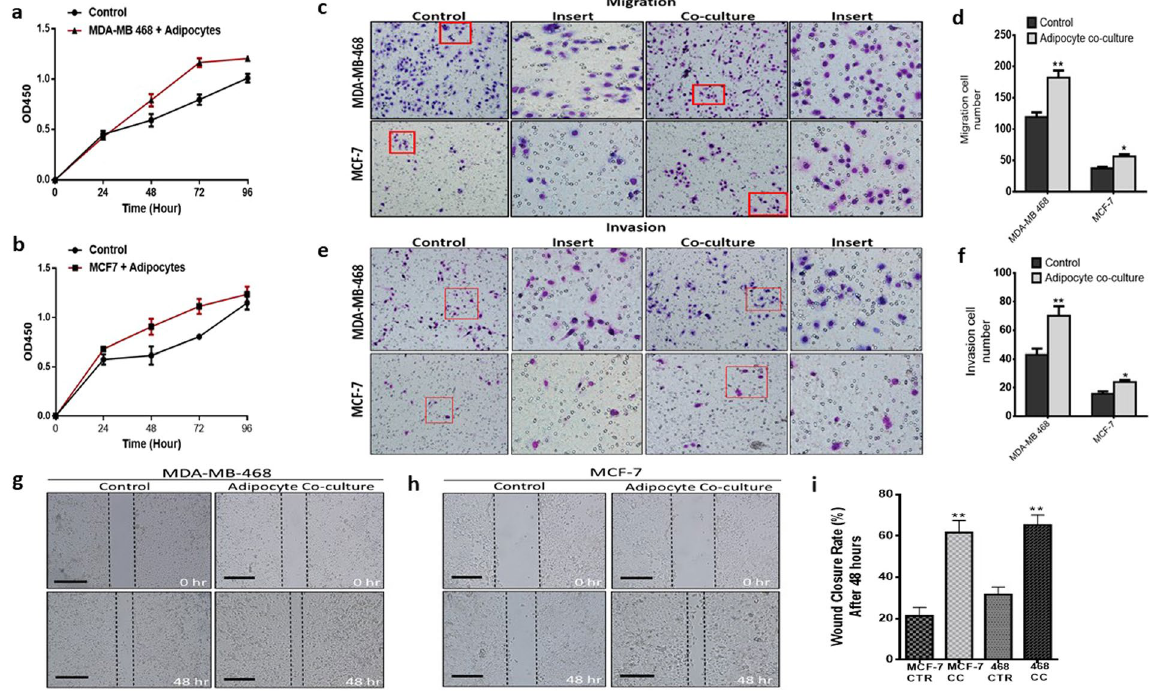
Figure 2. Human adipocytes enhances the aggressive characteristics of breast cancer. ( a,b ) Proliferation capabilities of co-cultured breast cancer cells assessed with the CCK-8 assay, compared with control cells (A: MDA-MB-468 and B: MCF-7). ( c ) Migration rate was examined using the transwell insert without matrigel. ( d ) Quantification of migration capabilities ability of MDA-MB-468 and MCF-7 breast cancer cells. ( e ) Invasion rate was examined using the transwell insert with matrigel. ( f ) Quantification of invasion capabilities ability of MDA-MB-468 and MCF-7 breast cancer cells. ( g,h,i ) Representative images of wound healing assay. Breast cancer cell motility accessed by a wound healing assay after 48 hours (magnification, x100), MDA-MB-468 and MCF-7 co-cultured breast cancer cells had a higher motility rates. All results are representative of 3 independent experiments. (Data indicate mean ± SD; *** p < 0.001; ** p < 0.01; * p <